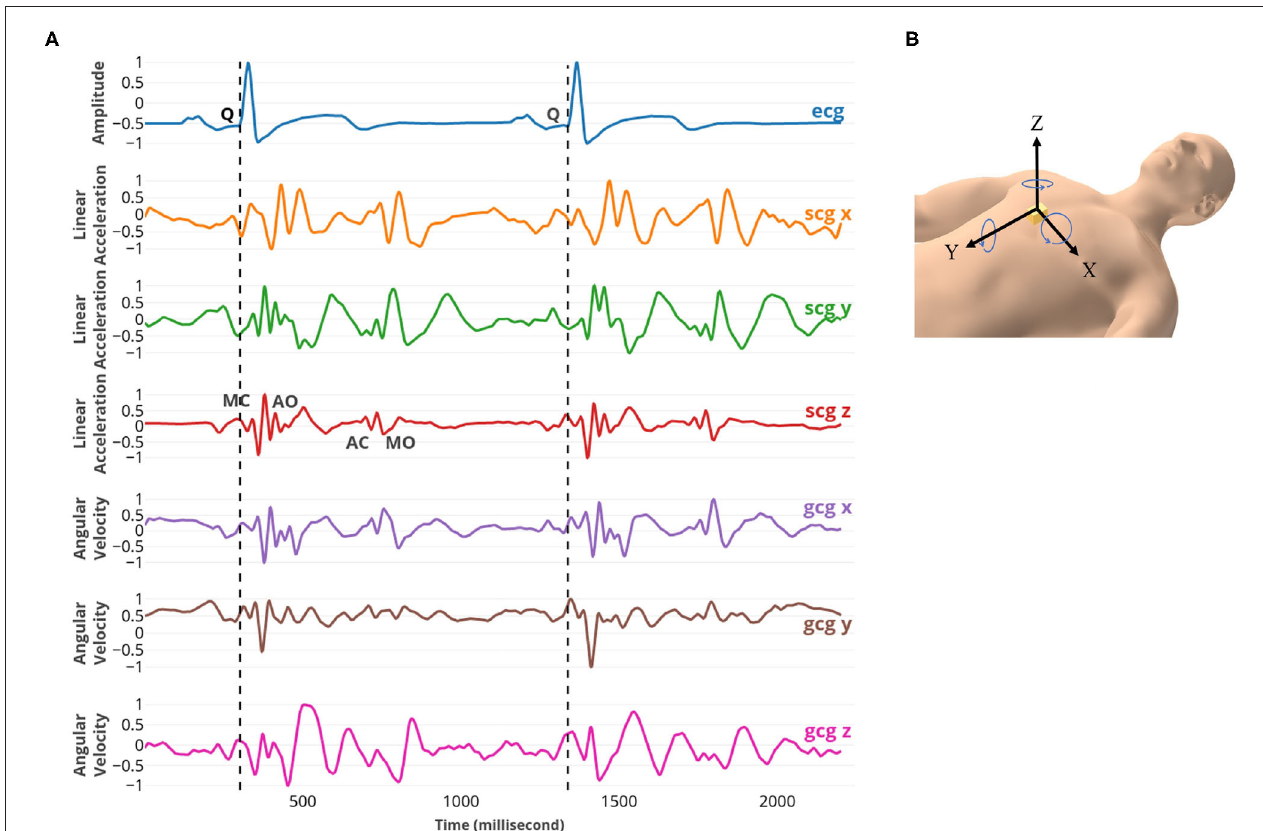
FIGURE 1 | (A) From top to bottom: ECG, SCG x, y, and z, and GCG x, y, and z signals captured simultaneously. The fiducial points MC, AO, AC, and MO were marked on SCG z. MC and MO points correspond to mitral valve closure and opening; AC and AO points correspond to the aortic valve closure and opening. (B) The position and the direction of the 3-axial micro-electro-mechanical (MEMS) joint accelerometer-gyroscope